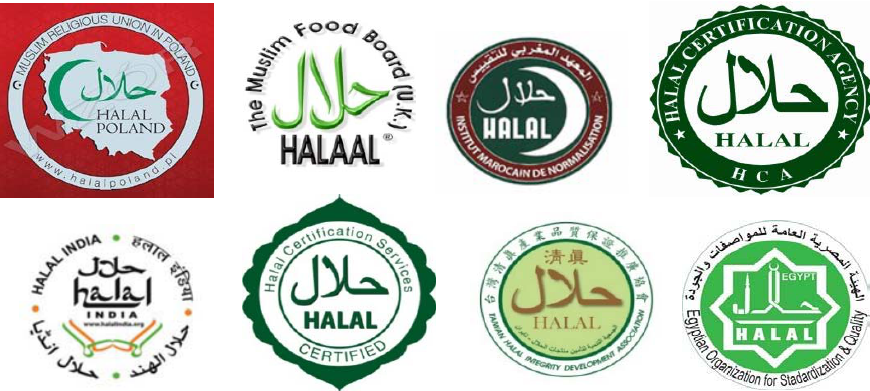
Figure 1. Some of the halal certification symbols for different countries. Source: [103].